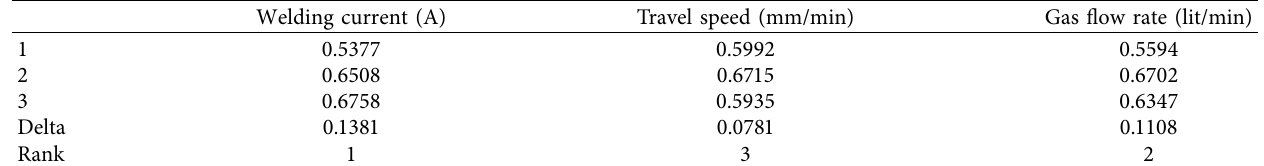
Table 5: Response table for